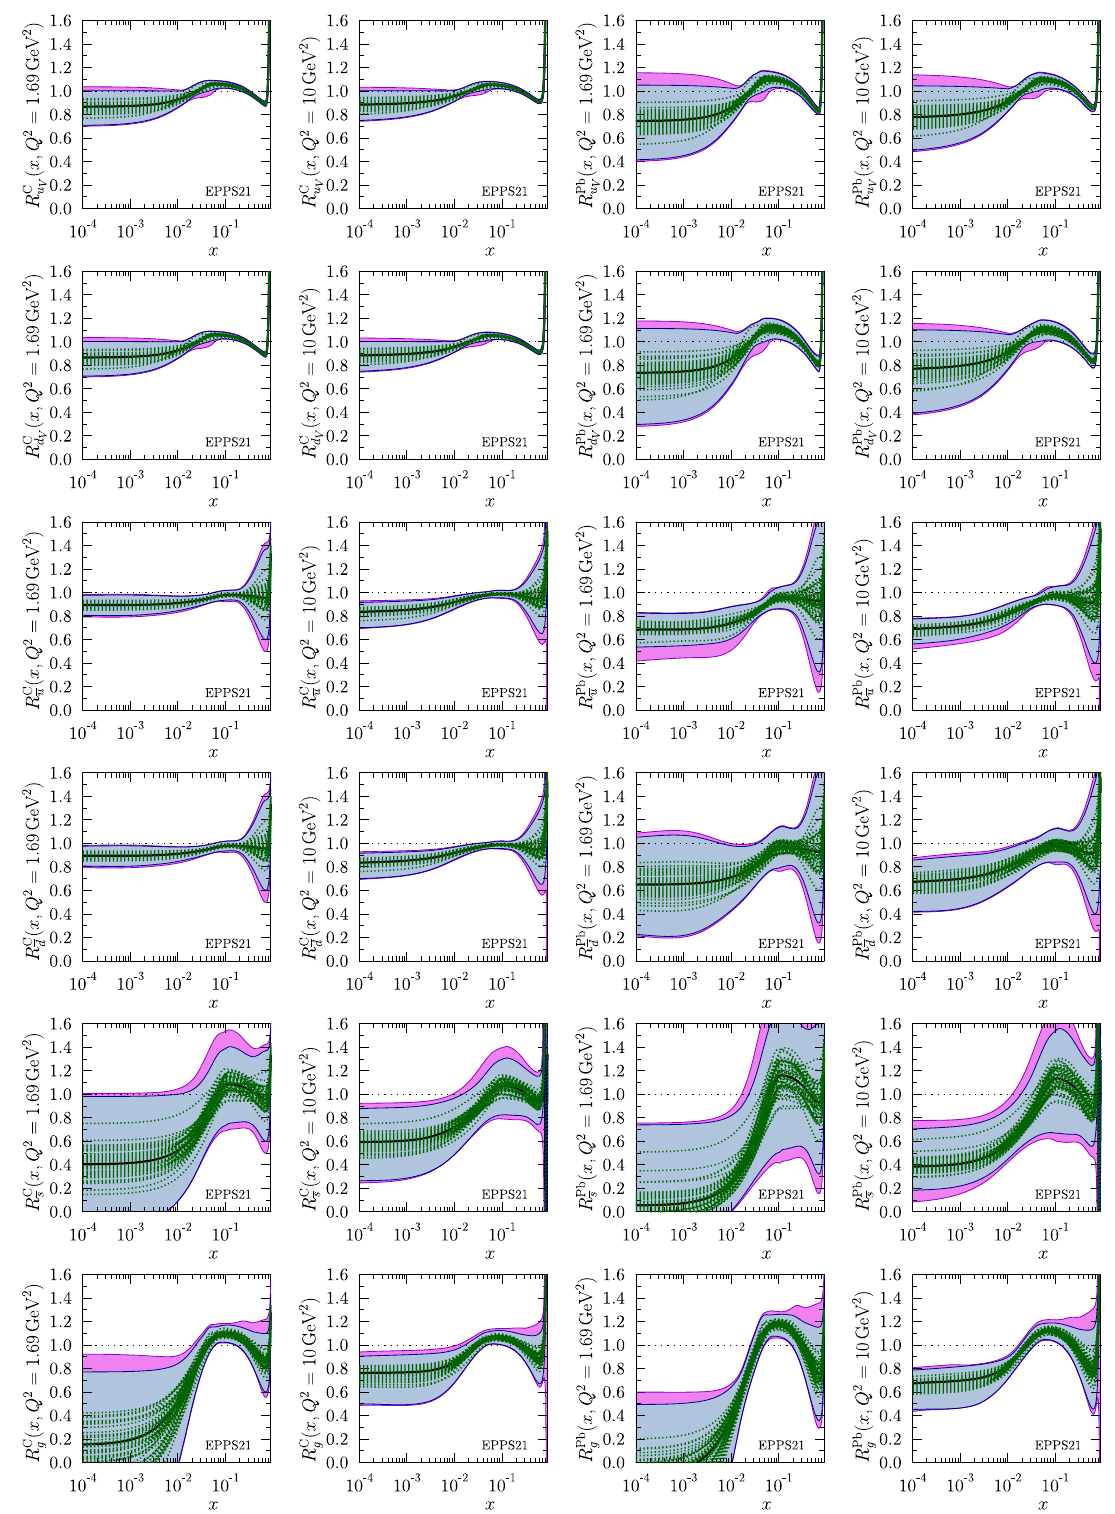
Fig. 8 The EPPS21 nuclear modifications of average nucleons in car- bon(twoleftmostcolumns)inlead(tworightmostcolumns)attheinitial scale Q 2 = 1 . 69GeV 2 and at Q 2 = 10GeV 2 . The central results are shown by thick black curves, and the nuclear error sets by green dotted